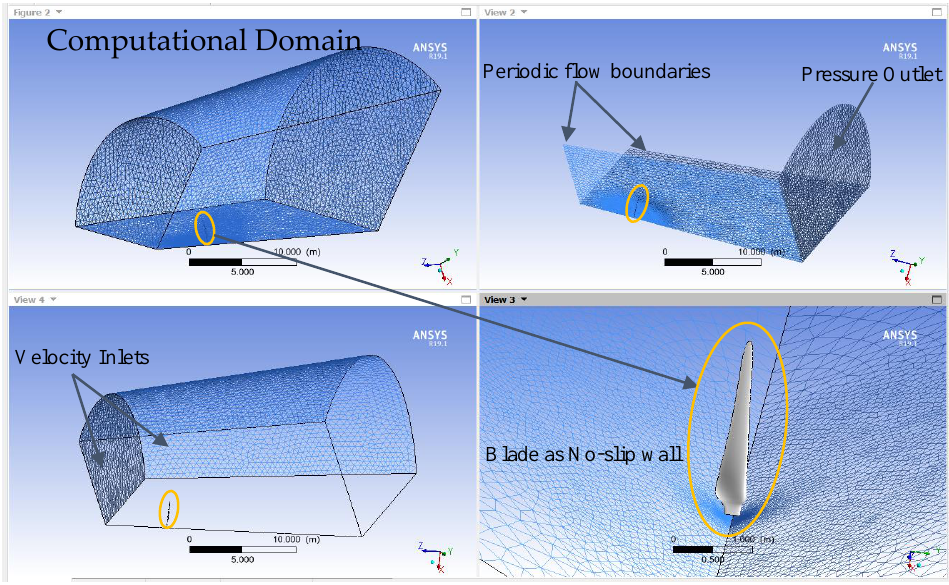
Figure 1. Computational-domain and boundaries of the computational fluid dynamics simulation.